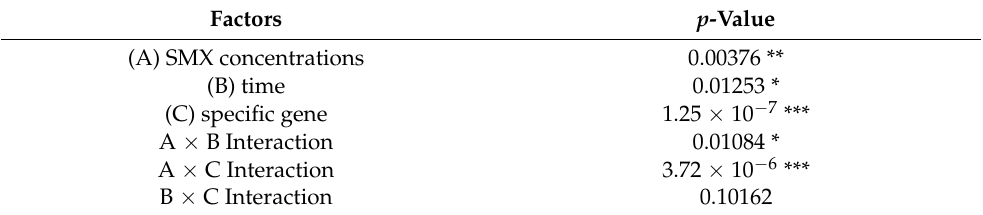
Table 2. SMX-ARGs ( sul 1 and sul 2) and intI 1 gene relative abundances at days zero and seven for each SMX concentration in MSC-experiment and control (C-MSC).